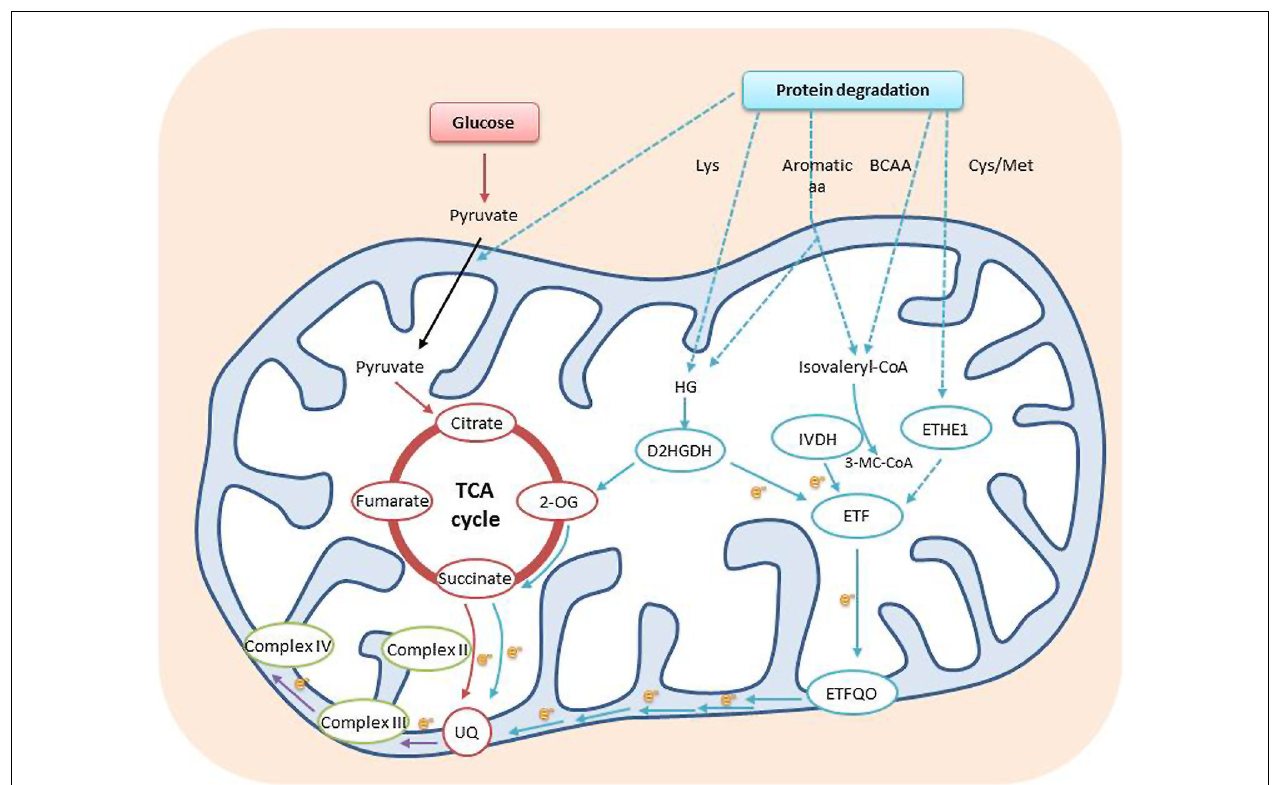
either by conversion to pyruvic acid or acetyl-CoA or by direct conversion to TCA cycle intermediates, such as 2-OG, and direct electron supply to the ubiquinone pool of the mitochondrial electron transport chain in plants. Dotted arrows represent possible transport processes and multi enzymatic reactions. Abbreviations: BCAA, branched chain amino acids; D2HGDH, 2-D-hydroxyglutarate dehydrogenase; e–, electron; ETF, electron transfer flavoprotein; ETFQO, ETF:ubiquinone oxidoreductase; ETHE1, ethylmalonic encephalopathy protein1; HG, hydroxyglutarate; IVDH, isovaleryl-CoA dehydrogenase; 3-MC-CoA, 3-methylcrotonyl-CoA; 2-OG, 2-oxoglutarate; TCA cycle, tricarboxylic acid cycle; UQ, ubiquinone (Adapted from Araujo etal., 2011; Krüssel etal.,